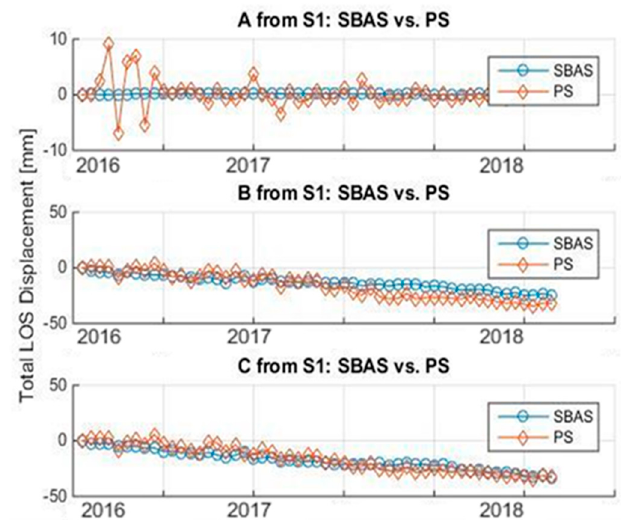
Figure 5. Mean LOS ground velocity of S1 ascending stack: the SBAS vs. PS cross-comparison analysis for the A, B and C selected sites of Figure 4.